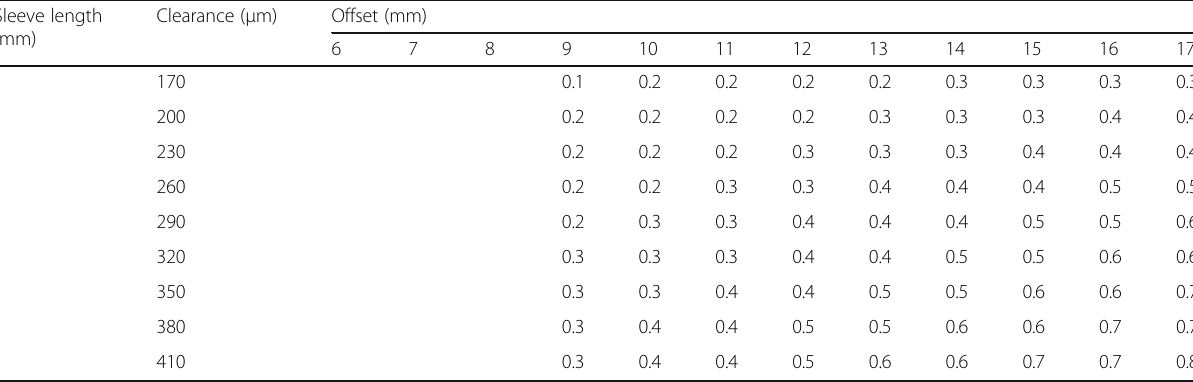
Table 4 Error at the neck (mm) (Continued)